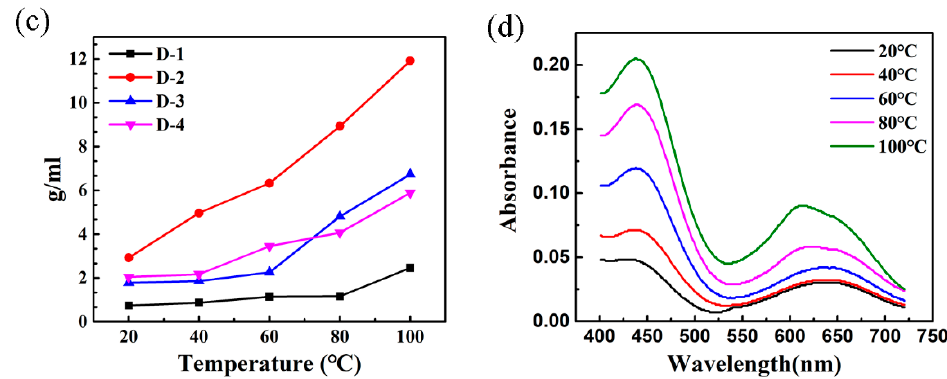
Figure 9. ( a ) The topography of wool fiber; ( b ) The topography of wool / acrylic blended fiber; ( c ) The solubility of these dyes under the different temperatures; ( d ) The absorbance change of D-1 with temperature.